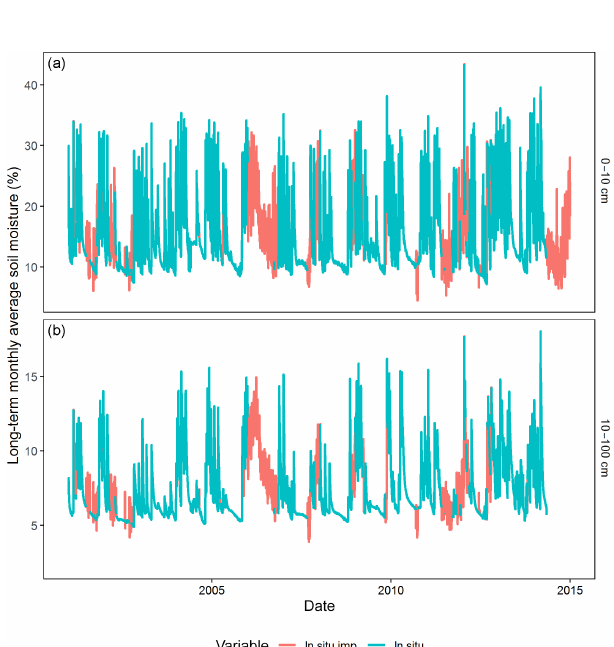
Figure A1. Daily (a) surface and (b) root-zone soil moisture time series at Skukuza showing the imputed parts (red) of the time series and the observed parts